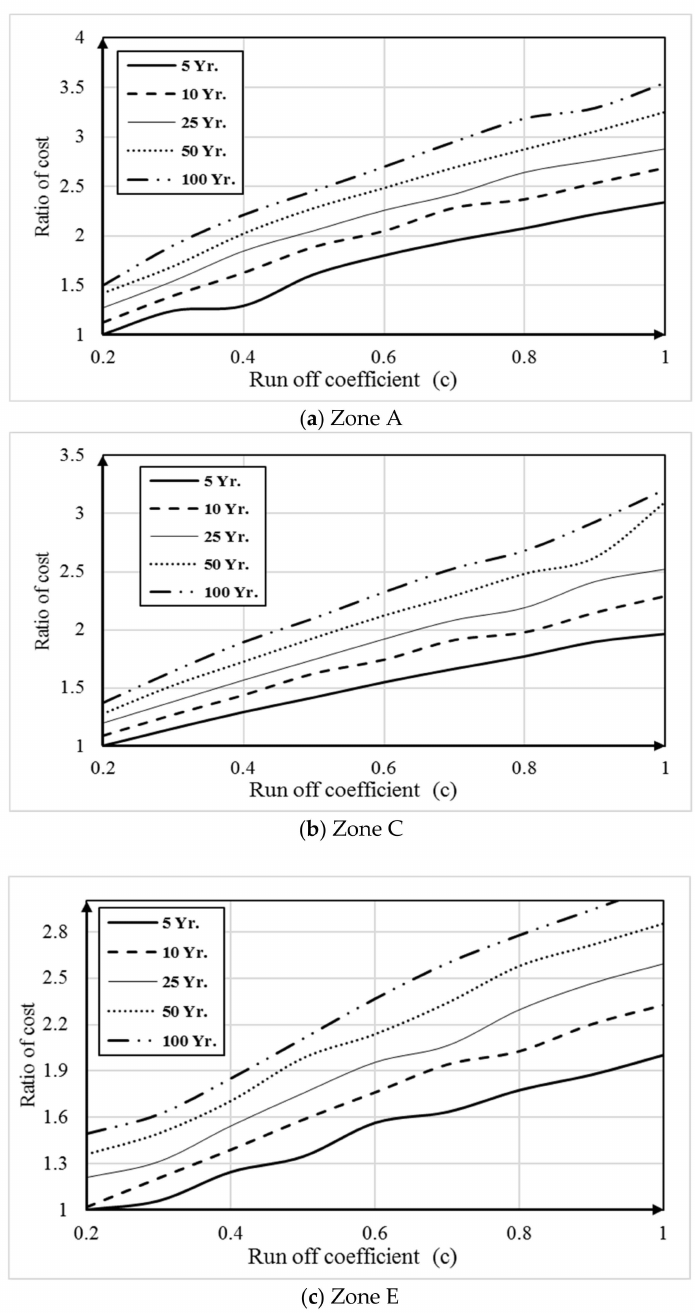
Figure 9. Relationship between runo ff coe ffi cient (C) and storm network cost of zones A ( a ), C ( b ) and E ( c ). The egression method was used to create an equation for the cost ratio based on the runo ff coe ffi cient and return period (Equation (5)). The confidence interval was equal to 94%. This equation was based on the available data for the three zones and can be applied to determine the cost ratio as